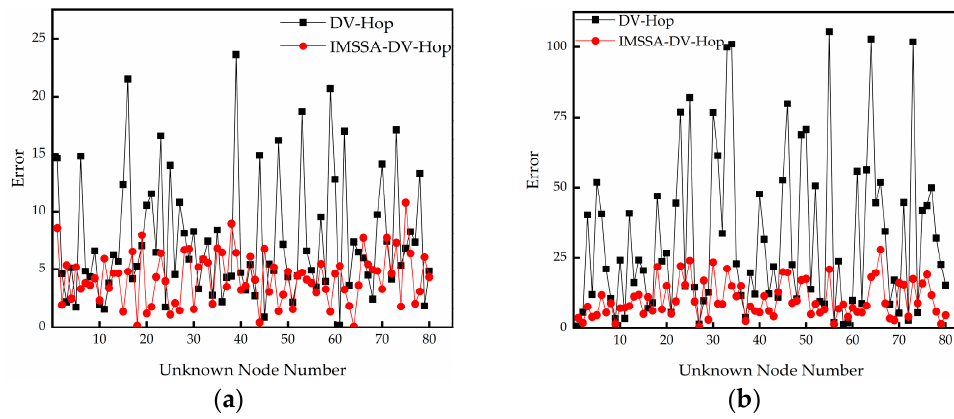
Figure 2. Ranging error diagrams: ( a ) square random topology; ( b ) C-shaped random topology.